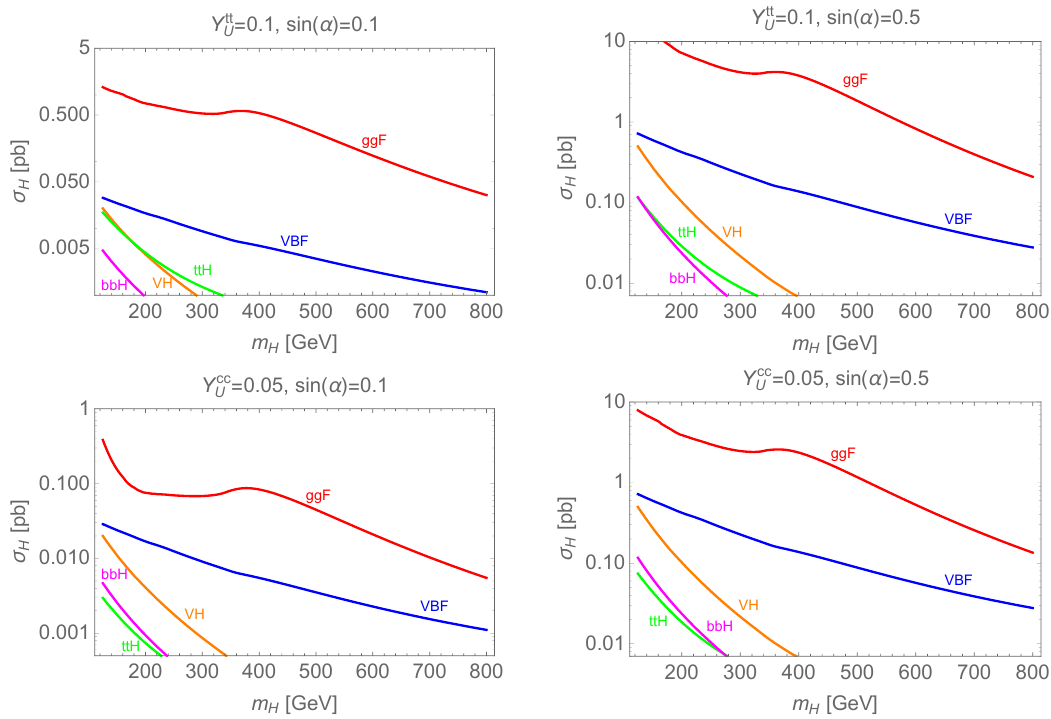
Figure 2. The production cross-section of the neutral scalar H for the 13 TeV LHC as a function of its mass. The production channels are color coded as follow: gluon-fusion (red), t (cid:22) tH (orange), b (cid:22) bH (magenta), VBF (blue) and VH (green). On the top row Y tt Y cc = 0 : 05. On the left pane sin (cid:11) = 0 : 1 and on the right pane sin (cid:11) = 0 : 5. Other Yukawa couplings U are taken to be